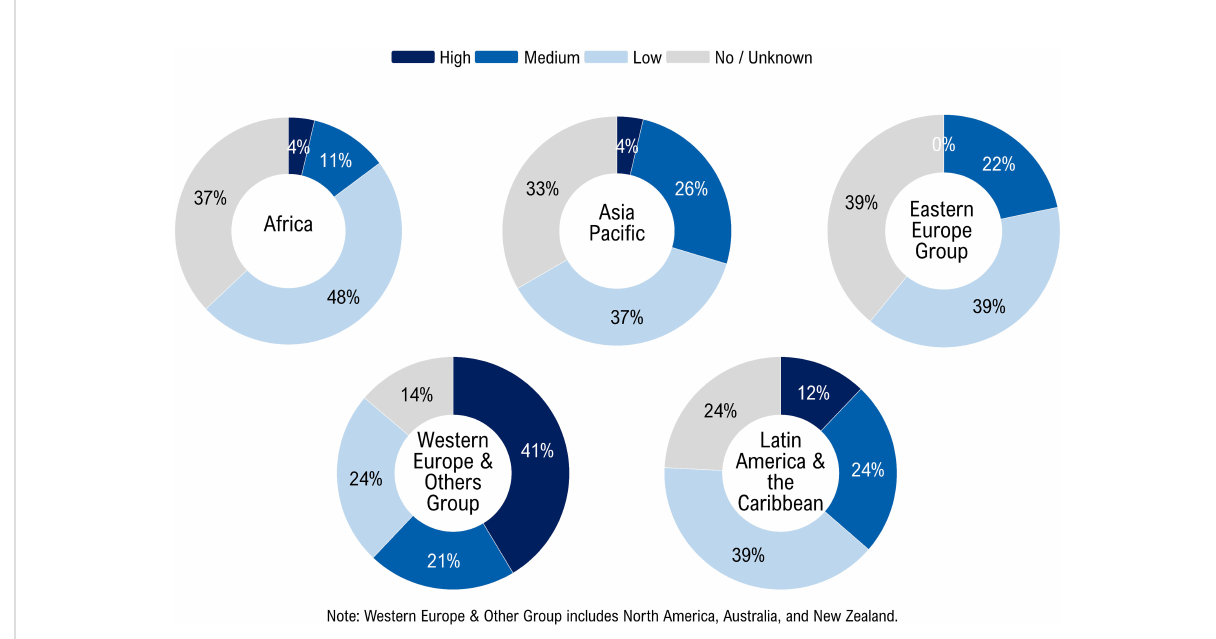
FIGURE 4 Global blue economy development by